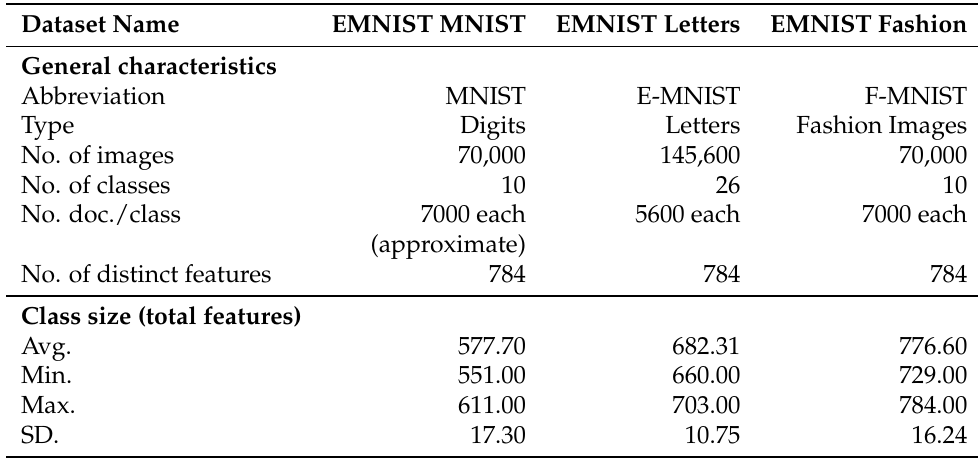
Table 1. Characteristics of experimental